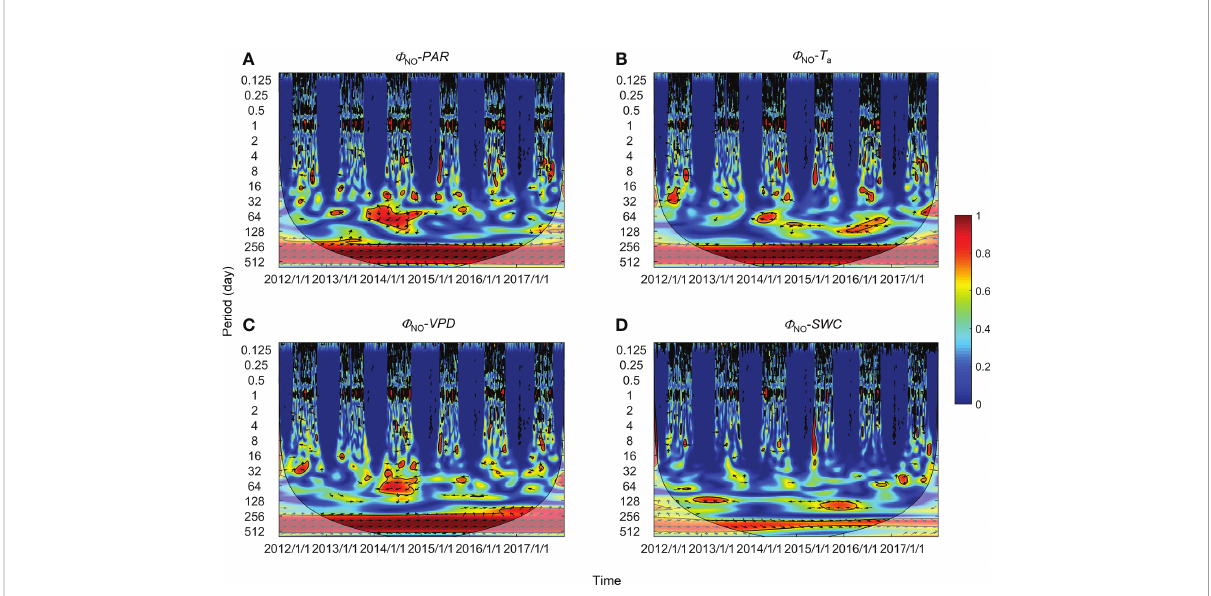
FIGURE 7 Wavelet coherence between regulatory thermal dissipation ( F NPQ ) and (A) photosynthetically active radiation ( PAR ), (B) air temperature ( T a ), (C) vapor pressure de fi cit ( VPD ), and (D) soil water content at a 0.3-m depth ( SWC ). The phase difference is shown by arrows. Arrows pointing upward indicate environmental factors leading F NPQ by 90°, whereas arrows pointing downward indicate environmental factors leading F NPQ by 270°. Arrows pointing left (or right) indicate environmental factors and F NPQ vary in-phase (or anti-phase). Black contour lines represent the 0.05 critical signi fi cance level. The thin arced lines denote the cone of in fl uence (COI) that delimits the region not affected by edge artefacts.